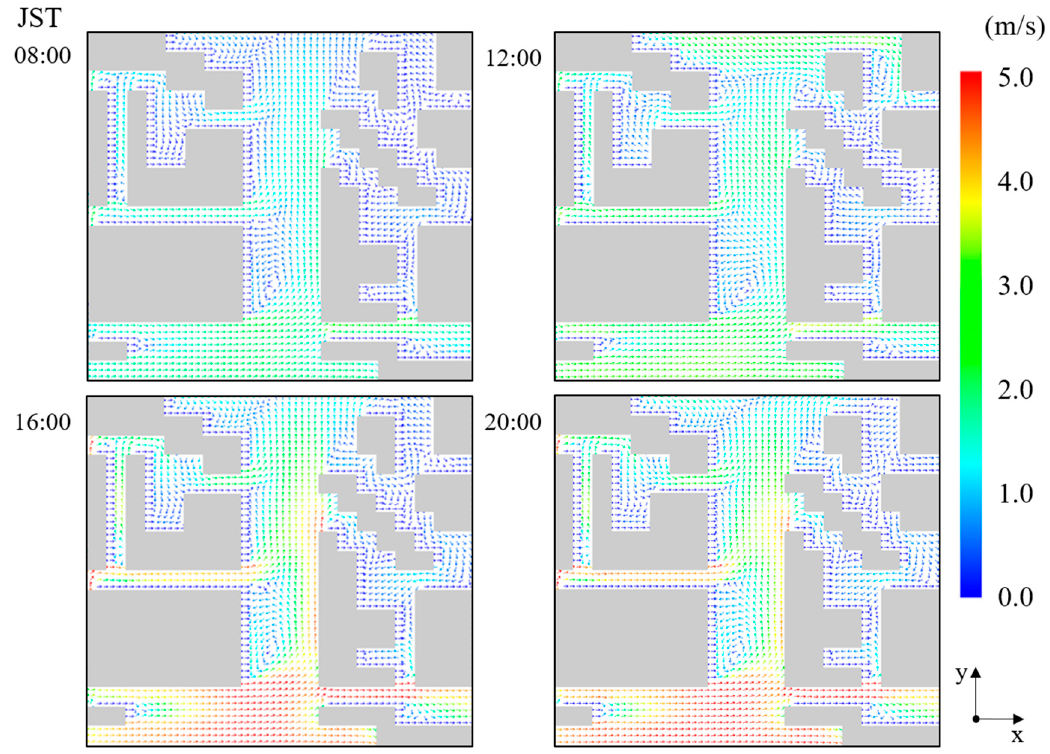
Figure 7. Airflow patterns at 08:00, 12:00, 16:00, and 20:00 JST, cross-section B-B’ view (Figure 2b).